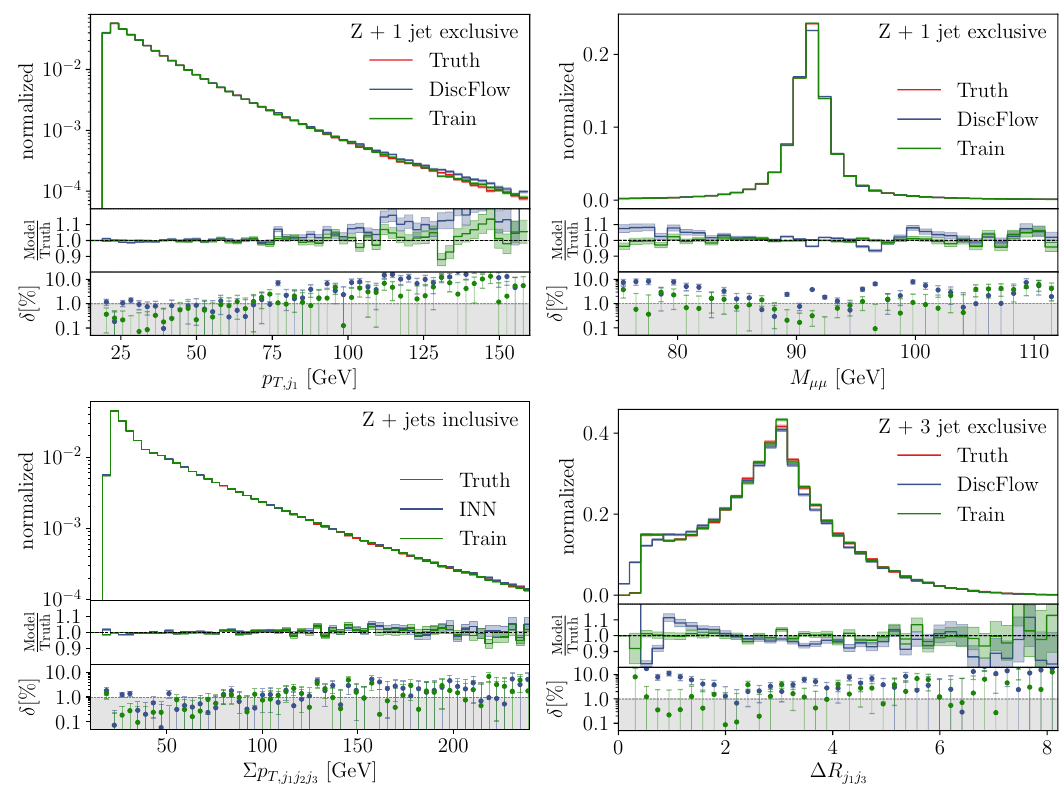
Figure 7: DiscFlow distributions for Z + 1 jet, Z + 3 jets, and an inclusive distribution from a combined Z + jets generation after joint generator–discriminator